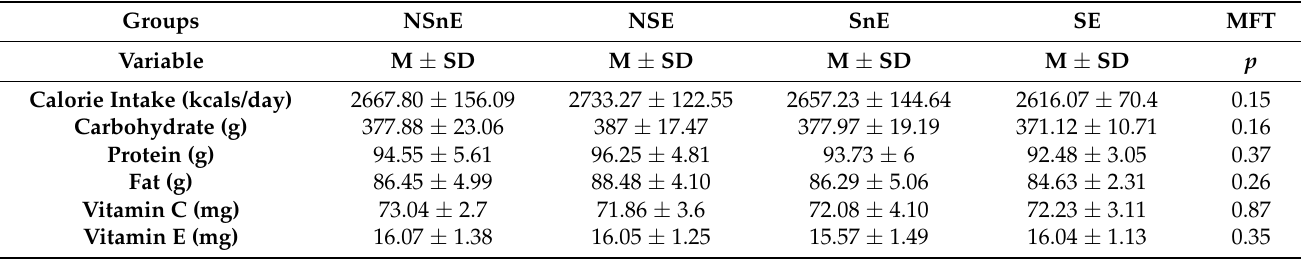
Table 2. The analysis of the average daily caloric and nutrient